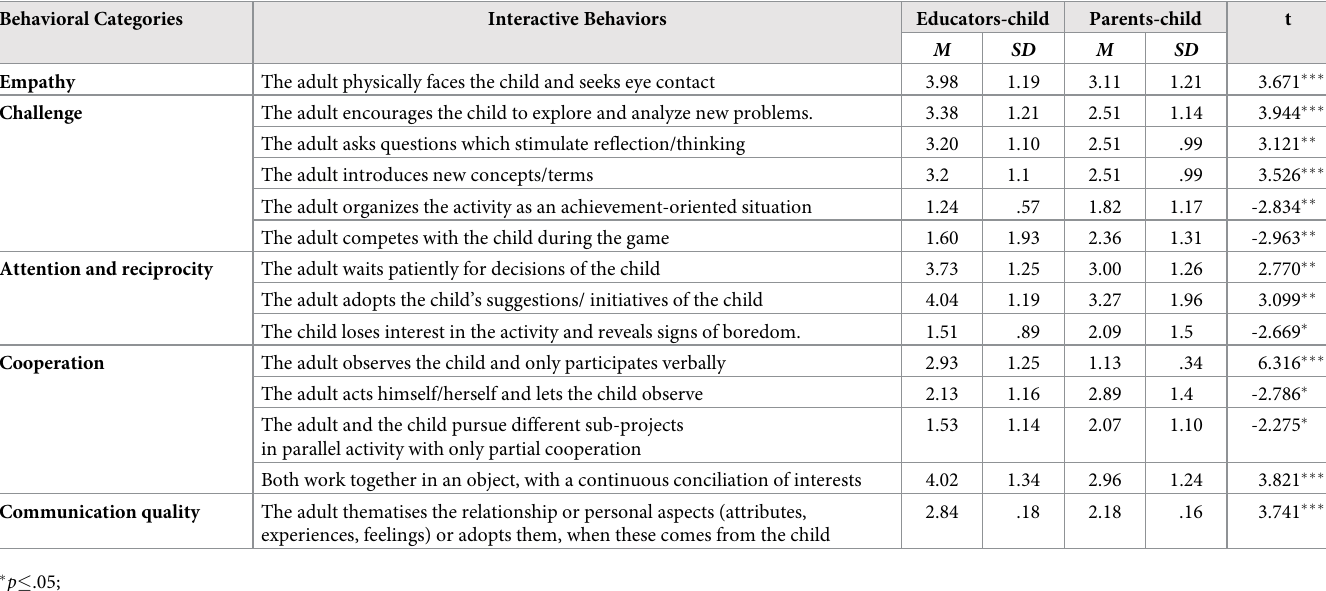
Table 4. Descriptive statistic and results of group differences test (dyads with educators versus dyads with parents) for adult interactive